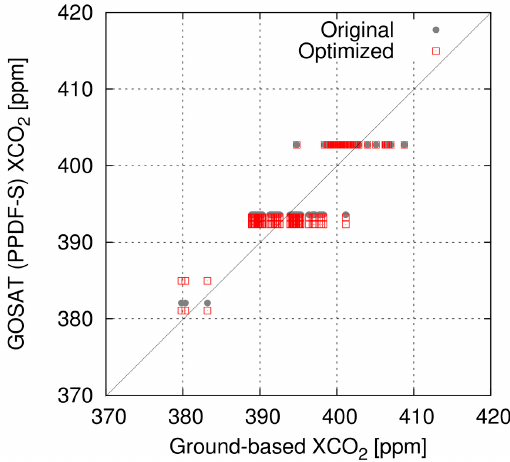
Figure 6. Comparison of XCO 2 retrieved by the PPDF-S method from the GOSAT data and that observed at Yekaterinburg using ground-based FTS. Gray dots present results of GOSAT data analyzed with the original parameter setting in the PPDF-S method. Red squares are those of the optimized parameter setting.